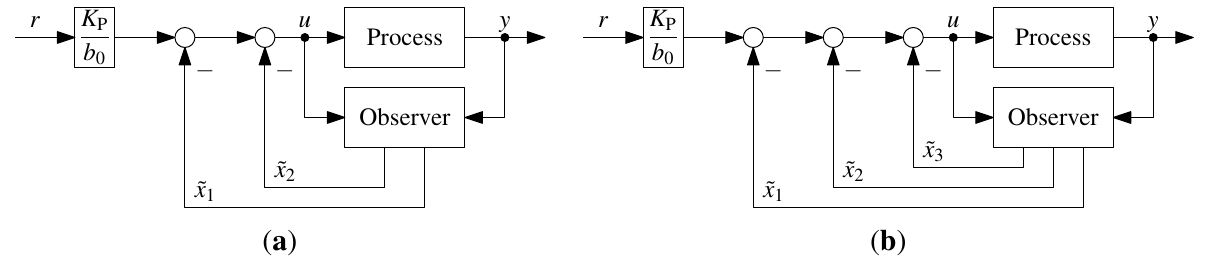
Figure 21. Control loop with modified ADRC structure and transformed state variables, ˜ x